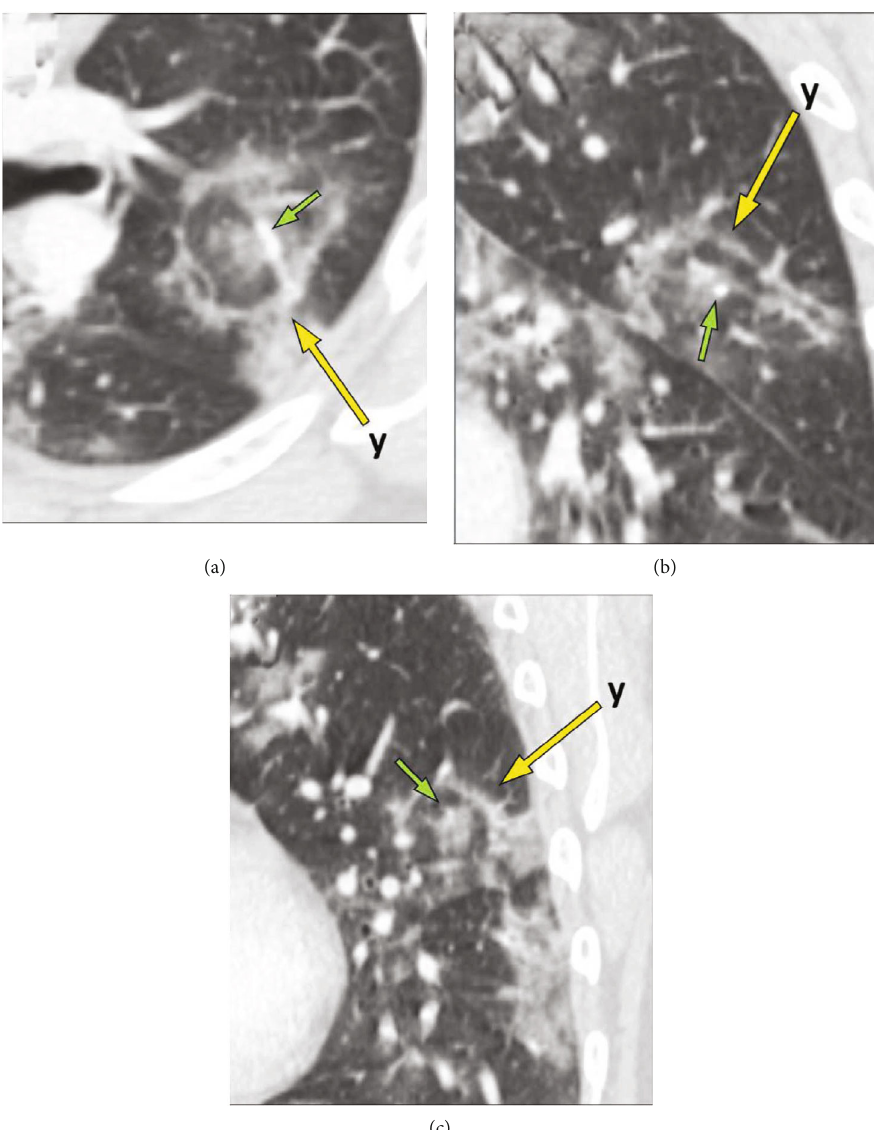
Figure 4: (a) Axial image at a level superior to Figure 3(a) depicting target lesion “ y ” (yellow arrow). The small green arrow shows the prominent central vessel. Oblique coronal (b) and sagittal (c) images through lesion “ y ” (yellow arrow), also showing prominent central vessels (small green